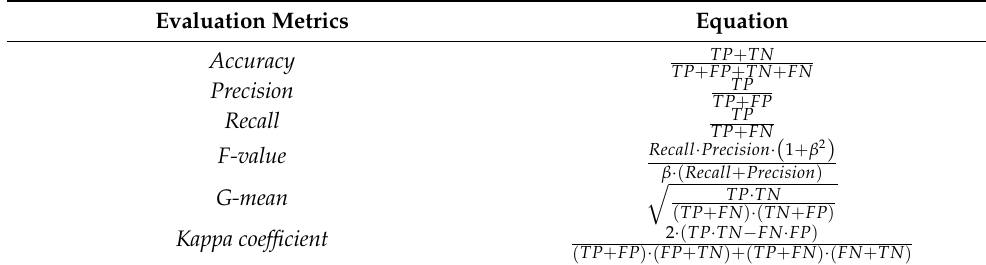
Table 3. The definition of evaluation metrics.